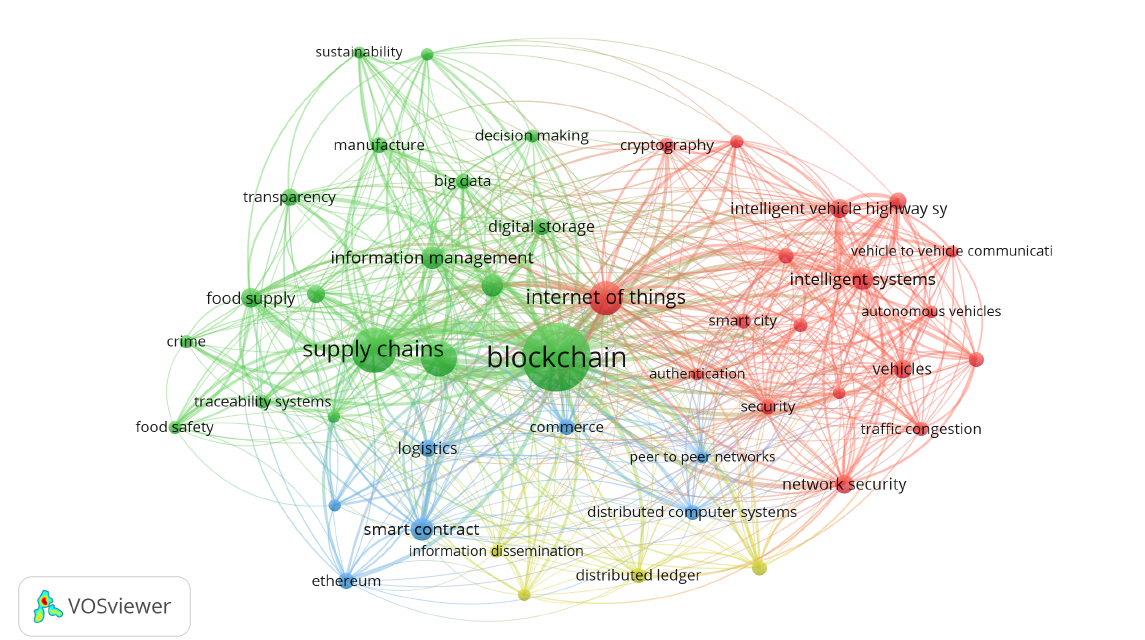
Figure 5. Output of the co-occurrence analysis on all the keywords of the 371 selected